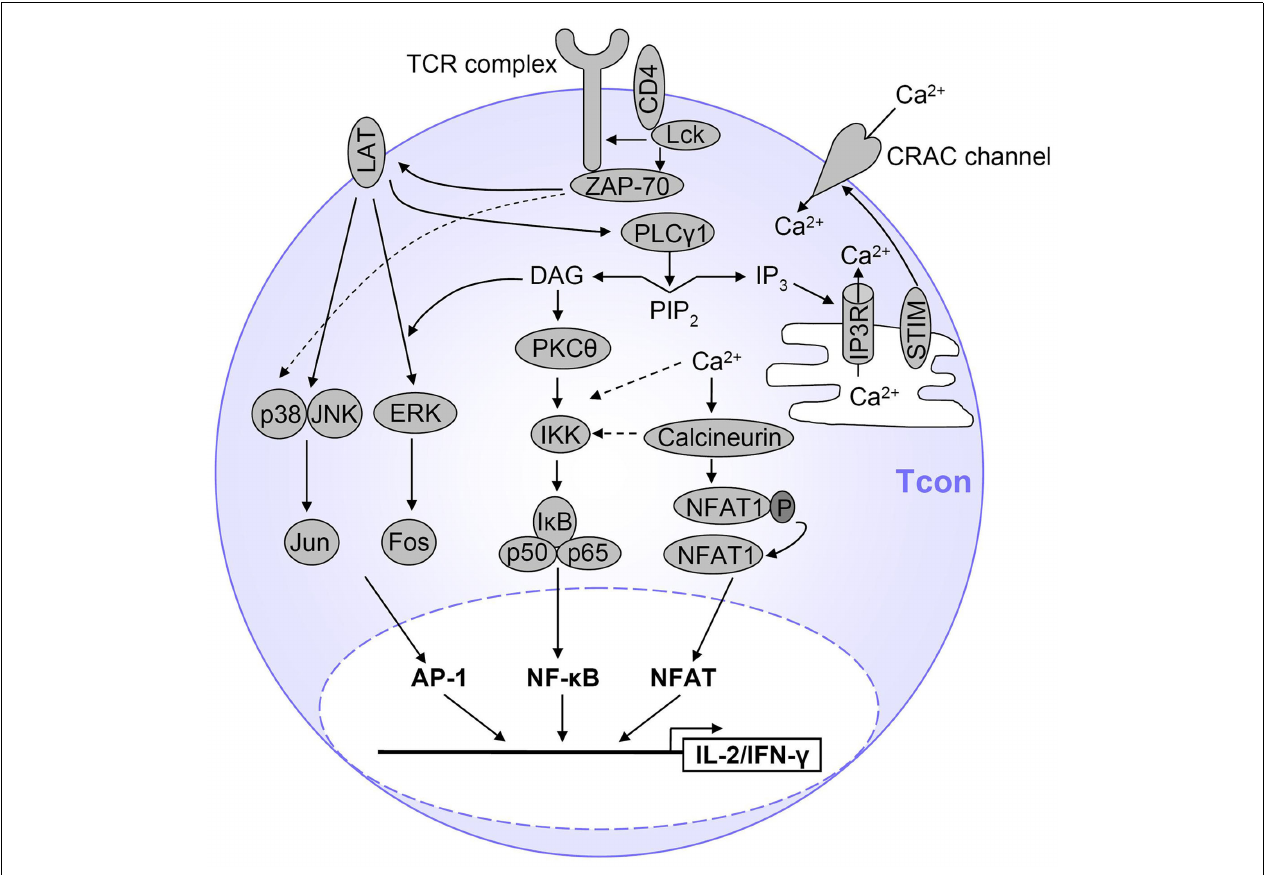
activation of the IKK complex and subsequent I κ B degradation, and Ca 2 + also contributes to NF- κ B activation. NFAT is activated by Ca 2 + influx which activates the NFAT-dephosphorylating phosphatase calcineurin. Only the major pathways are displayed here and represent a simplified view ofTCR signaling. Details are described in the